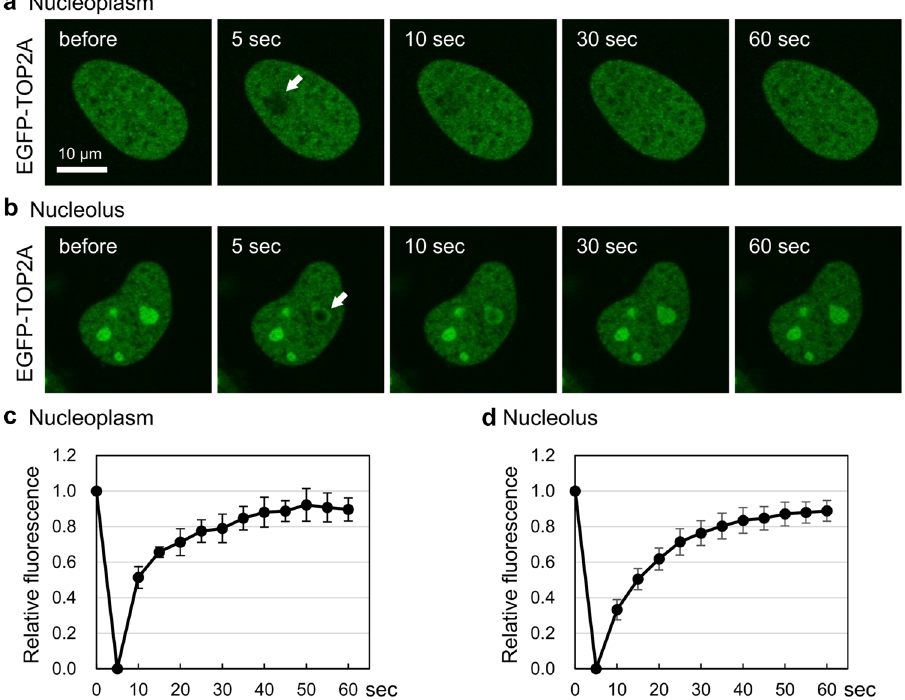
Figure 3. EGFP-TOP2A is highly mobile in the nucleoplasm and nucleolus. ( a ) Representative images of FRAP analysis of EGFP-TOP2A in the nucleoplasm. A small area of the nucleoplasm (shown with a white arrow) of a HeLa cell expressing EGFP-TOP2A was photobleached, and fluorescence images were captured at the indicated time points. ( b ) Representative images of FRAP analysis of EGFP-TOP2A in the nucleolus. A HeLa cell expressing EGFP-TOP2A was incubated with 25 mM 2DG and 10 µM CCCP for 20 min, and photobleaching in a small area of the nucleolus (shown with a white arrow) was carried out. ( c, d ) Quantification of fluorescence signals of EGFP-TOP2A in the nucleoplasm ( c ) and in the nucleolus ( d ). Fluorescence images were captured at 5 s intervals. Photobleaching was conducted at 5 s. Average values of relative fluorescence and SD were calculated (n =